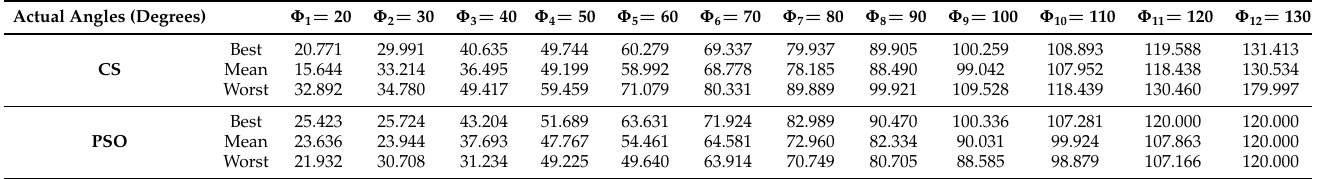
Table 7. Calculation of accuracy for twelve targets at 0 dB SNR.